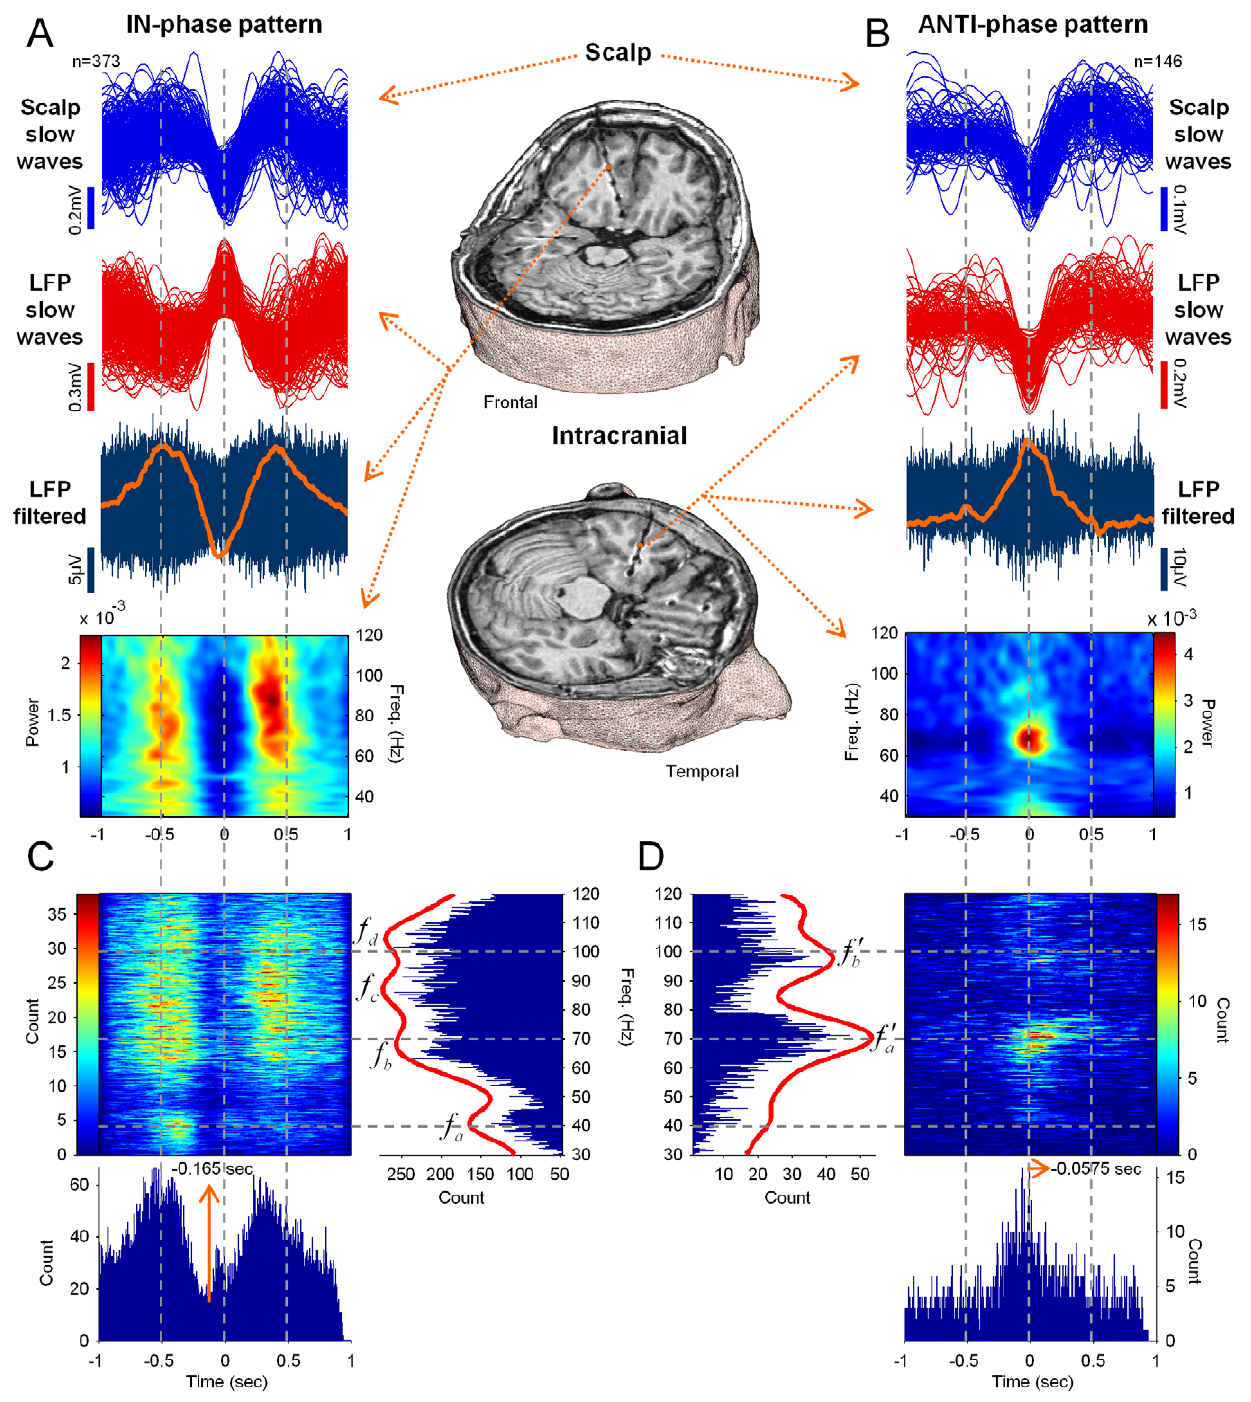
Figure 3. Two patterns of phasic modulation of gamma oscillations by the slow waves. ( A–B ) Examples of IN-phase and the ANTI-phase modulation patterns of gamma oscillations recorded in intracranial contacts in the cingulate gyrus (subject P15 ) ( A ) and the superior temporal sulcus (subject P18 ) ( B ), respectively. From Top to Bottom : Superimposed scalp slow waves aligned around their central peak; Simultaneously recorded intracranial LFPs, also showing slow components; Intracranial filtered (30–120 Hz) signals with the average RMS activity (orange line); Average of their time-frequency representations. ( C–D ) Total number of gamma events, associated with IN-phase and ANTI-phase patterns respectively, detected along frequency (30–120 Hz) and time (2-seconds window around the scalp negative peak) for all patients (n=19) and all analyzed contacts (n=233). For IN-phase and ANTI-phase patterns, the cumulative histograms of their frequency distributions were illustrated ( Top-Right and Top-Left ) with the corresponding regression curves ( red lines ). Several dominant peaks were identified at f a < 41, f b < 67, f c < 87, f d < 105 Hz and f 9 a < 70, f 9 b < 97 Hz. The cumulative histograms of their first detection times (relatives to the intracranial central peak of the slow waves) are also illustrated ( Bottom ).